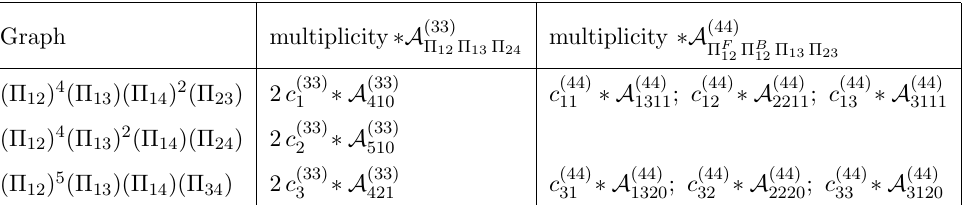
Table 4 . Relevant graphs and the corresponding hexagon contributions for the sub-extremal four- point function hB 0 B 5 O 2 O 2 i 7